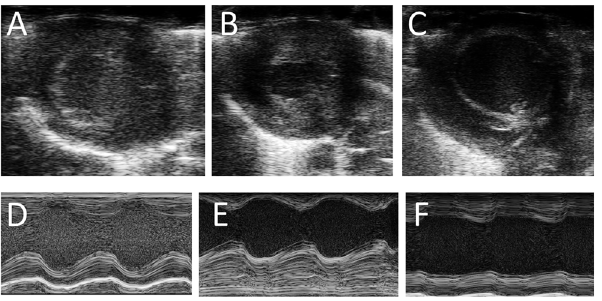
Fig 2. Echocardiography of healthy and pressure-overloaded rat hearts. Baseline echocardiography of healthy rat heart in B-Mode (A) and M-Mode (D). Rat heart 3 weeks after TAC with thickened myocardium and reduced end-systolic left ventricular diameter in B-Mode (B) and M-Mode (E). Rat heart 6 weeks after TAC with thinned myocardium and increased end-systolic left ventricular diameter in B-Mode (C) and M-Mode (F). Representative images.